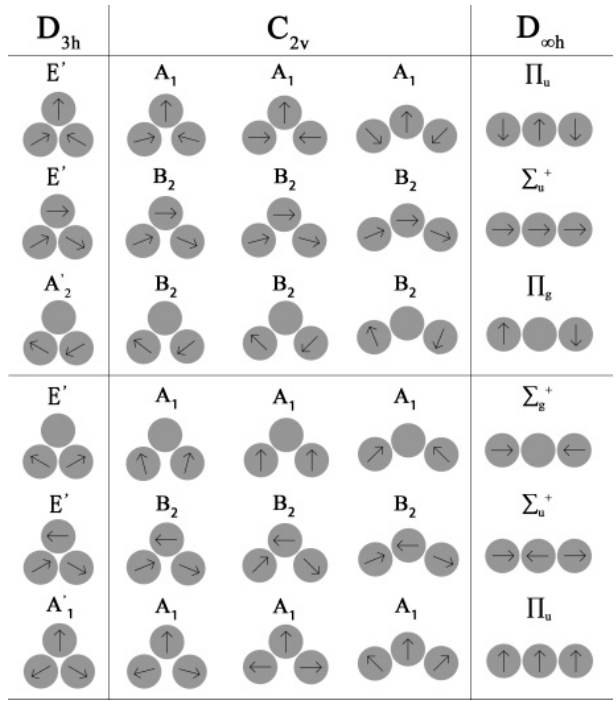
Figure 2. Surface charge density distributions of typical trimeric graphene plasmonic trimers.